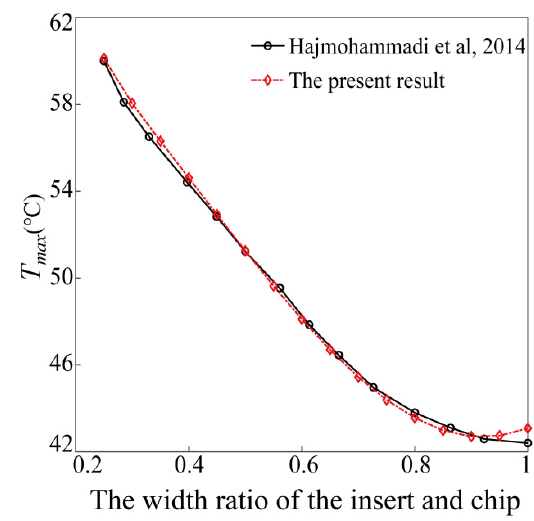
Figure 2. Data comparison with literature [24].